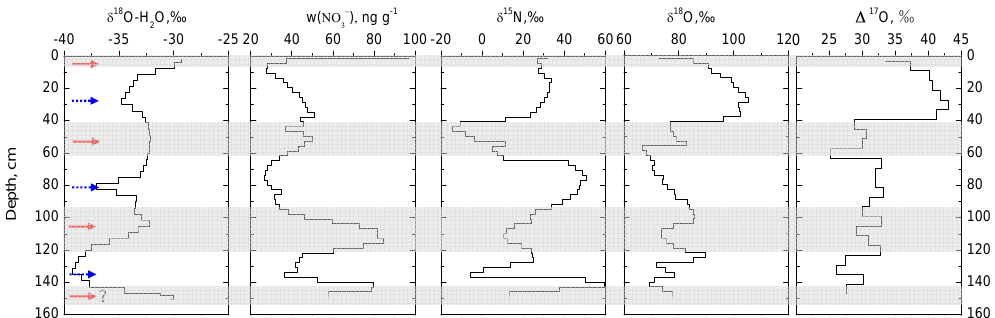
Fig. 7. Seasonality in w (NO 3- ), δ 15 N, δ 18 O and Δ 17 O of NO 3- in the P1 snowpit. Red solid arrows and blue dashed arrows represent the middle of the identified warm and cold seasons, respectively, and shaded areas denote warm seasons (see text). One seasonal cycle represents one δ 18 O(H 2 O) peak to the next. Seasonal assignment of snow near the pit base is subject to uncertainty due to the limited coverage and absent comparison with a preceding cold season.